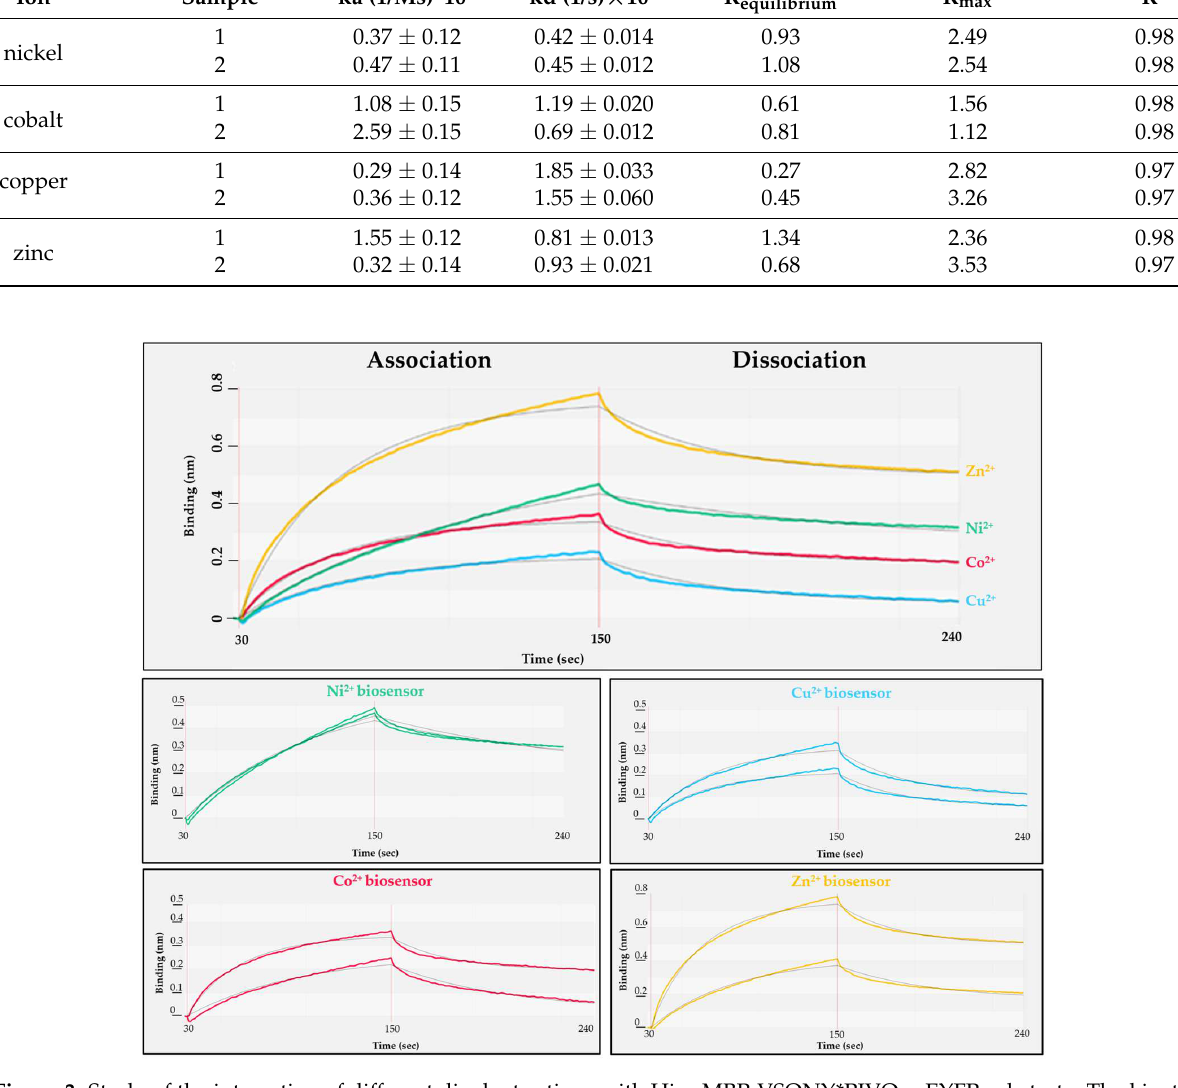
Figure 3. Study of the interaction of different divalent cations with His 6 -MBP-VSQNY*PIVQ-mEYFP substrate. The kinetic parameters determined for the cations are shown in Table 2. Results of two experiments are represented for each cation. The grey lines show fitting of data to 1:1 binding model by BLItz Pro